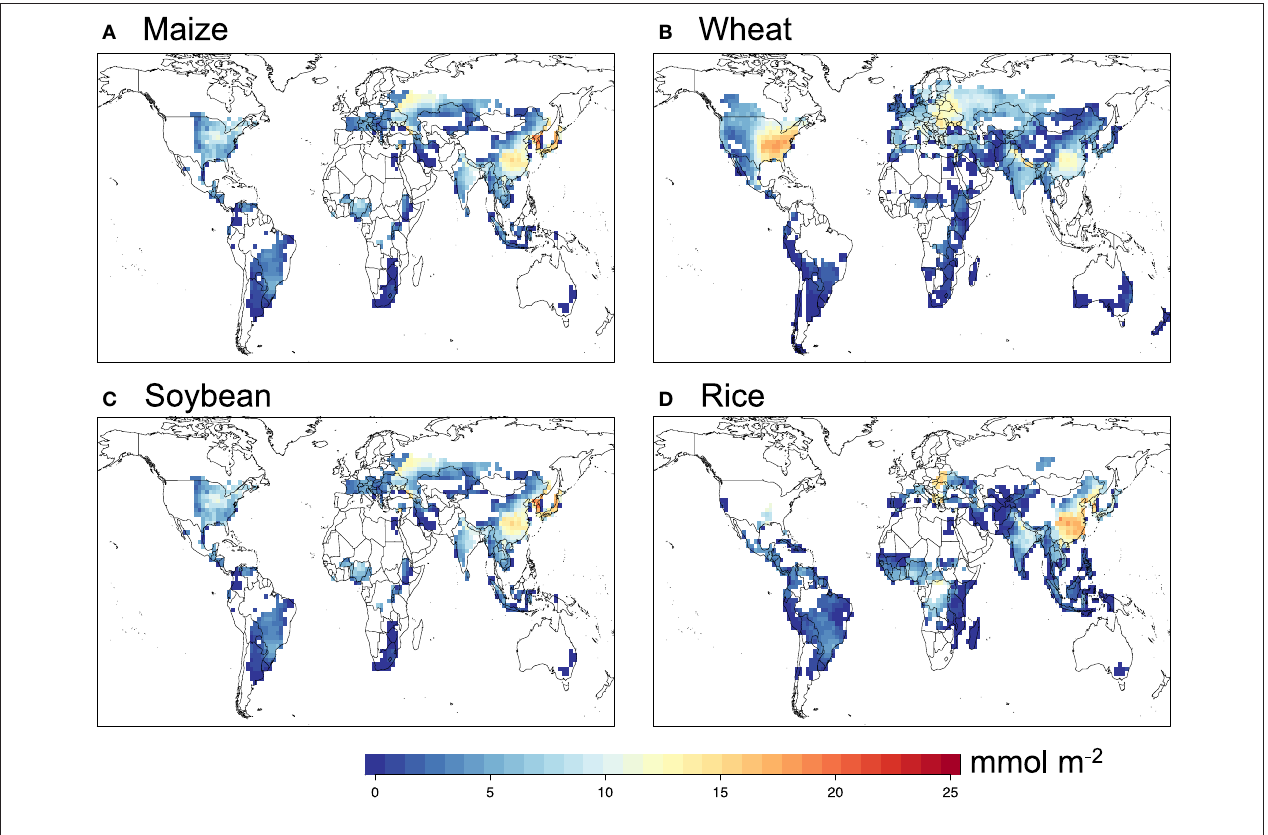
FIGURE 3 | Simulated POD 3 for (A) maize, (B) wheat, (C) soybean, and (D) rice with the FBB method.